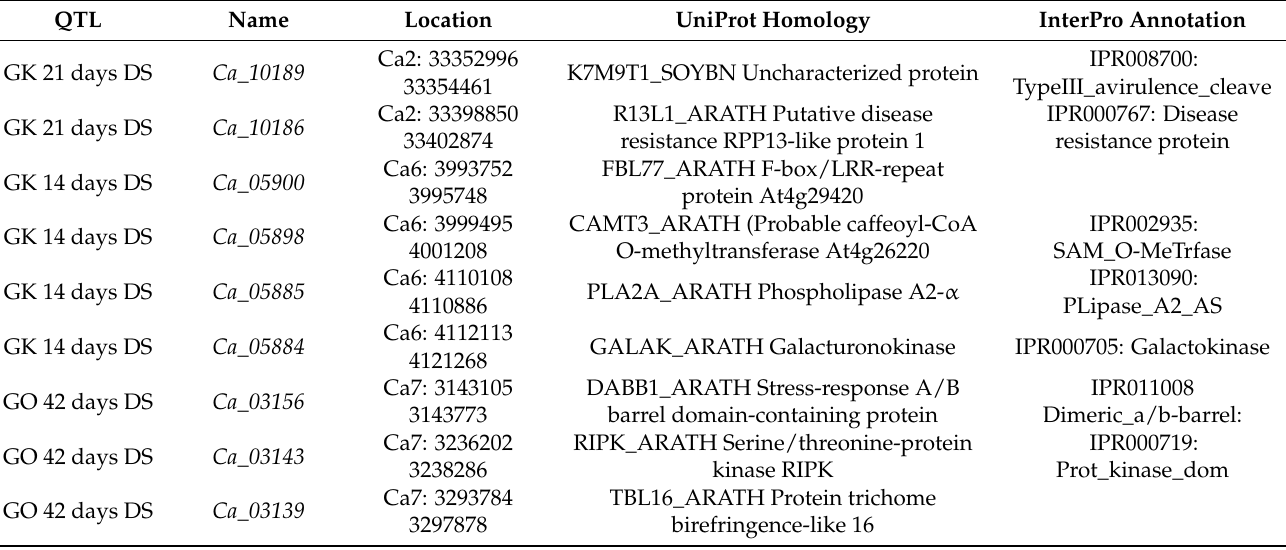
SOYBN = Glycine max . The top InterPro annotation is given where